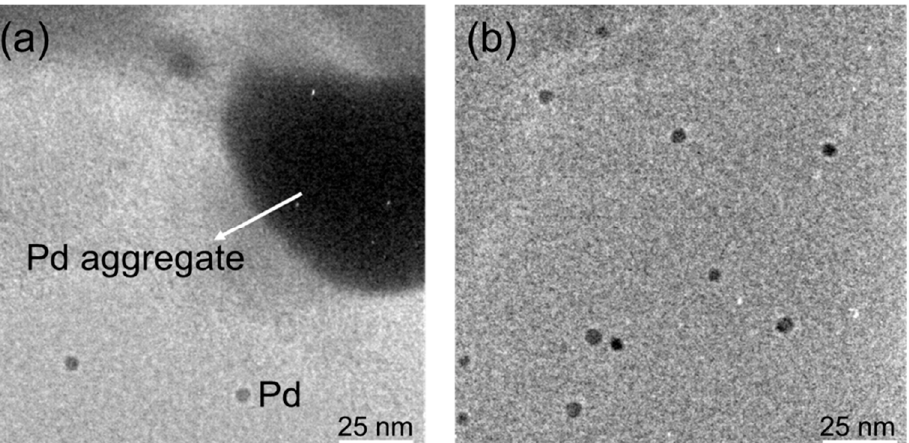
Figure 4. TEM images of Pd / AC catalyst surface: ( a ) after 5 min of microwave irradiation at the fixed microwave frequency (FFM) of 6.65 GHz; ( b ) after 60 min of microwave irradiation with variable frequency microwaves (VFM) in the frequency range 5.85–6.65 GHz.